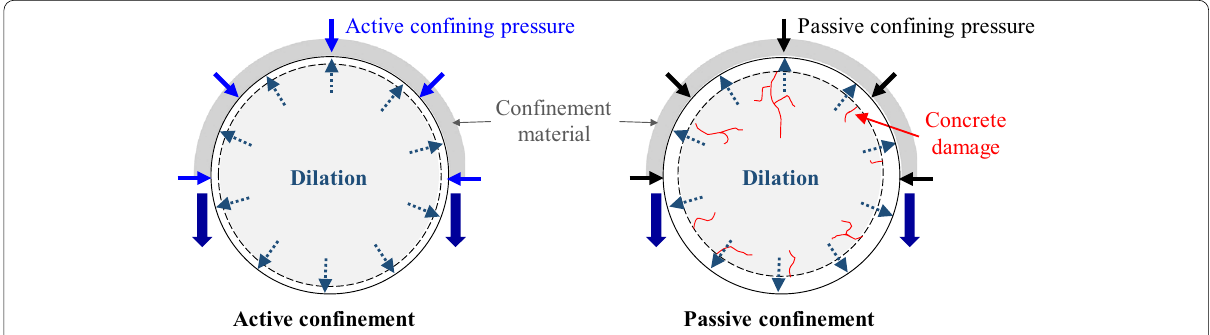
Fig. 1 Comparison of active and passive confinement